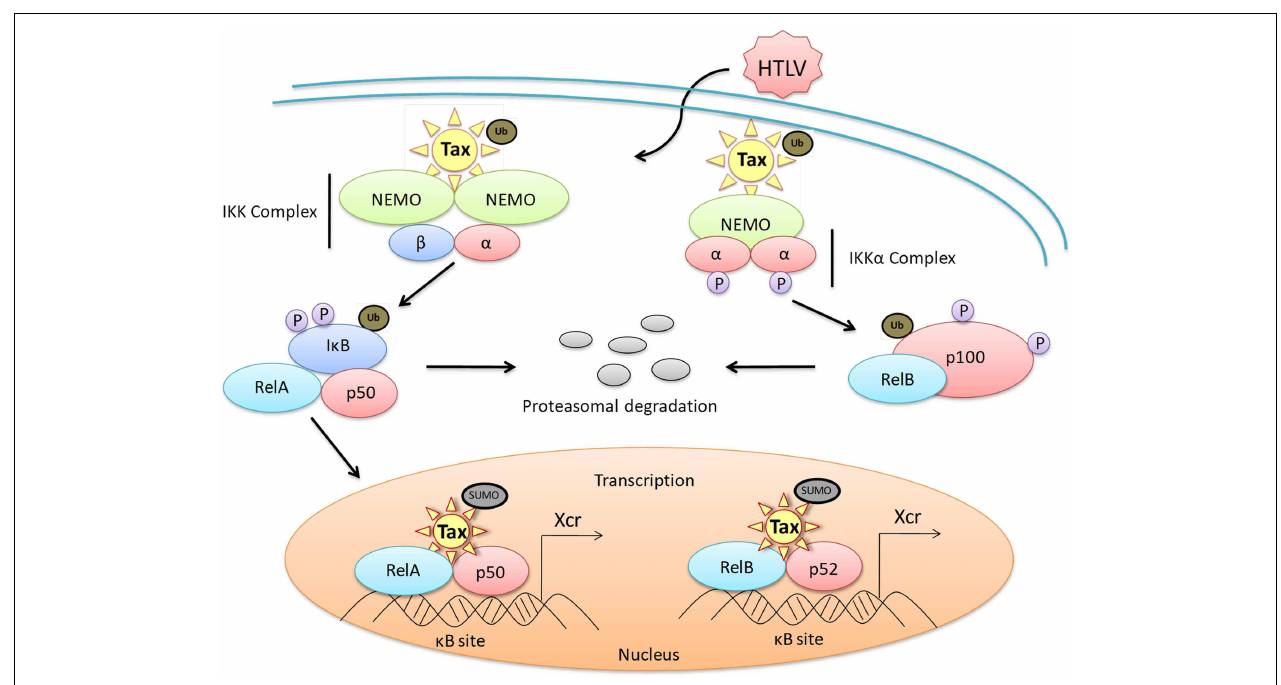
degradation of I κ B through the proteasome pathway. RelA is subsequently activated and translocates into the nucleus where sumoylatedTax recruits RelA toTax nuclear bodies, drivingTax-mediated NF- κ B transcription. Dysregulation of the non-canonical pathway occurs when biquitinatedTax interacts with the IKK α complex and activates the processing of the precursor proteinp100 to p52.This promotes the recruitment of RelB to the nucleus for activation ofTax-mediated NF- κ B transcription. Xcr,